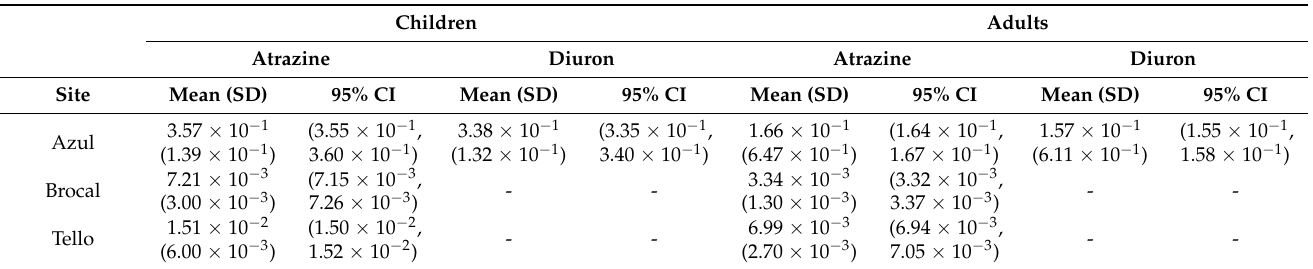
Table 3. Summary statistics for HQ of pesticides through Monte Carlo